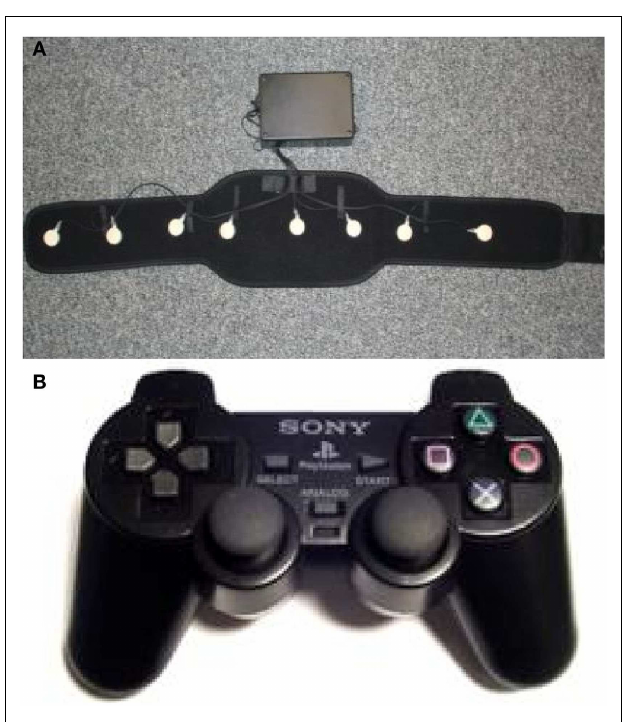
FIGURE 1 | Hardware interface used in addition to a standard LCD monitor: (A)TactaBelt, and (B) PlayStation 2 dual-shock controller .